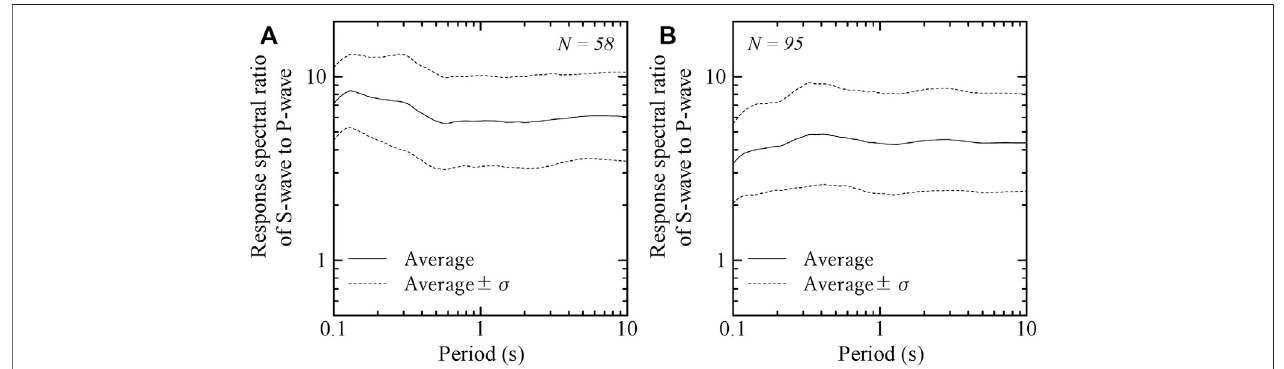
FIGURE 6 | Estimated site-speci fi c SI ratios of S-wave to P-wave for a time-window of 10.24 s at KS and SS stations.